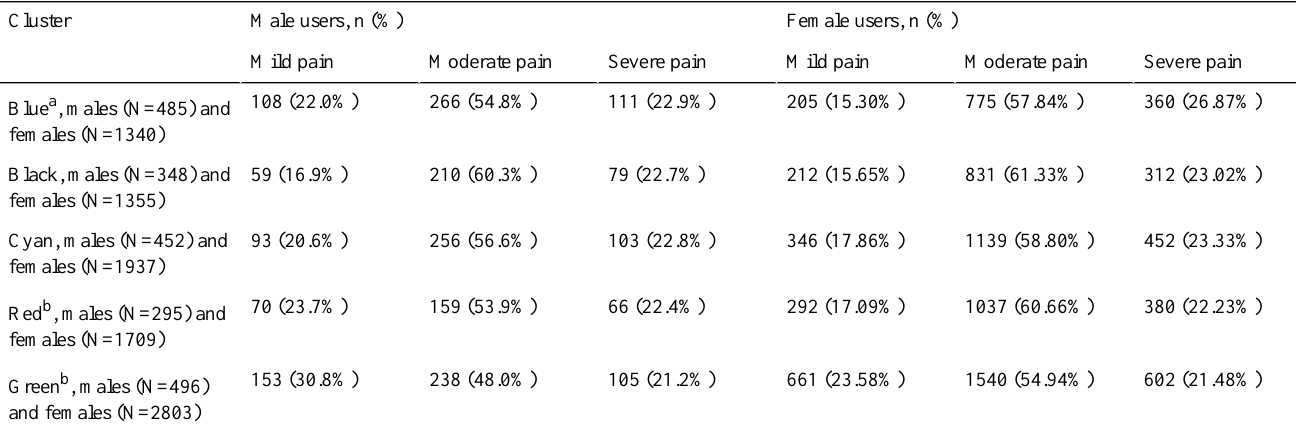
Table 6. Number and percentage of male and female users by pain severity groups within each cluster.